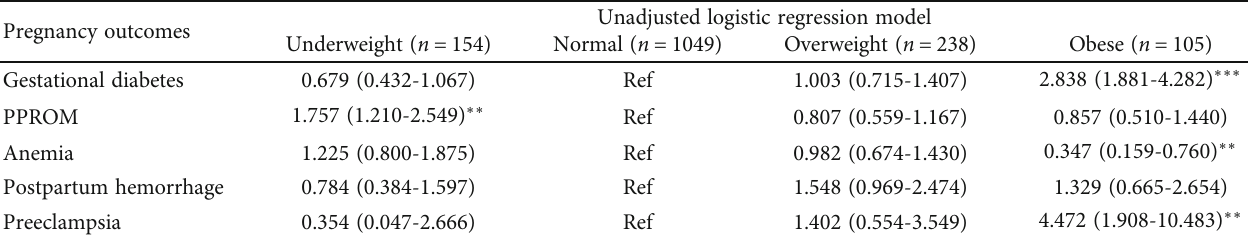
Table 2: The association between prepregnancy BMI and pregnancy outcomes, unadjusted logistic regression model.